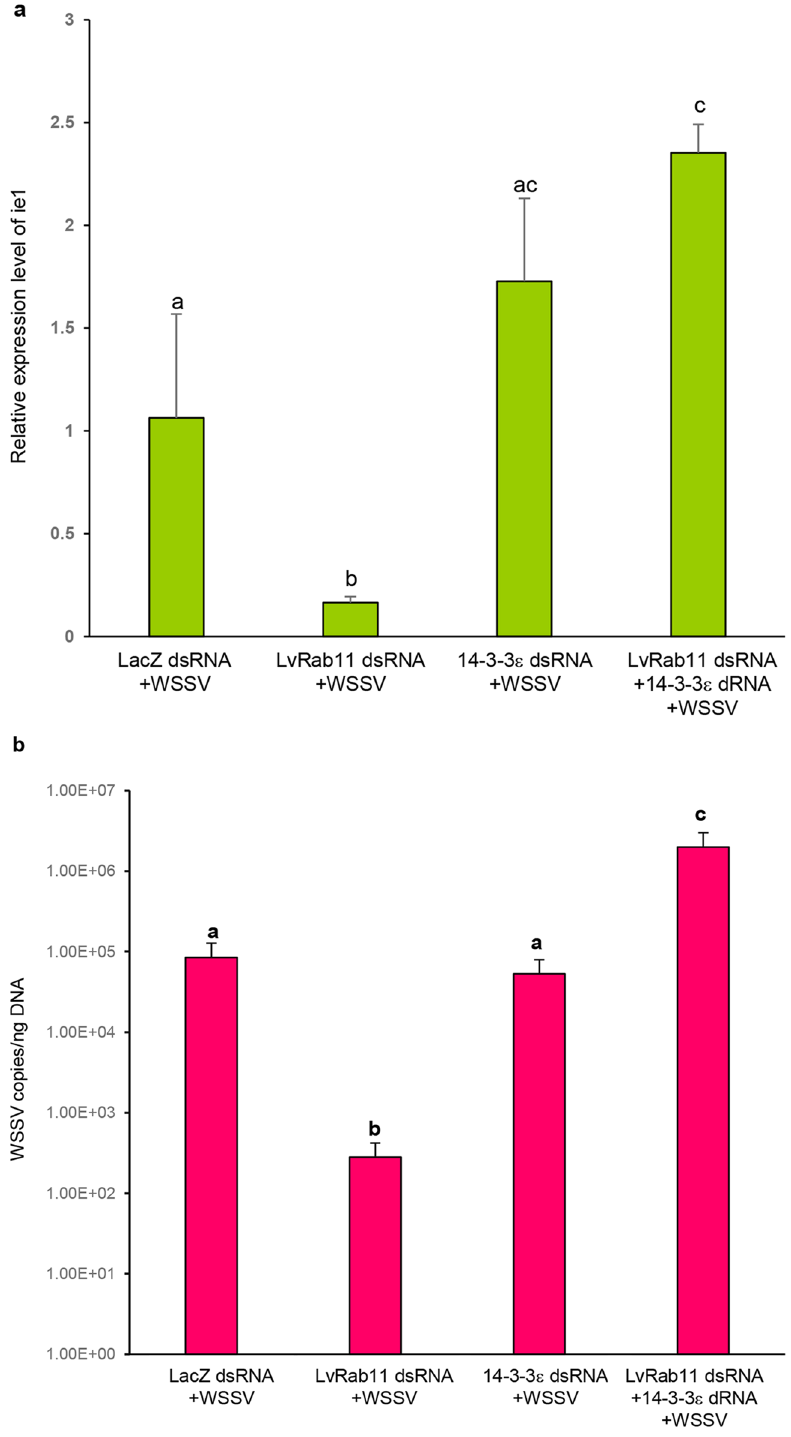
Figure 9. Effect of LvRab11 and 14-3-3ε dsRNA gene silencing in WSSV-challenged shrimp. ( a ) Relative expression of ie1 transcript was detected in shrimp at 48 h after WSSV infection. ( b ) Suppression effect on WSSV copy number was monitored in shrimp challenged with WSSV. The data represent means ± standard deviations, n = 3/group. Different letters indicate statistically significant difference between four groups ( p <